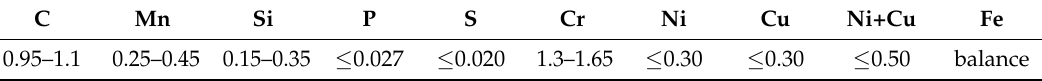
Table 3. The chemical composition of 100Cr6 steel (weight percentage,